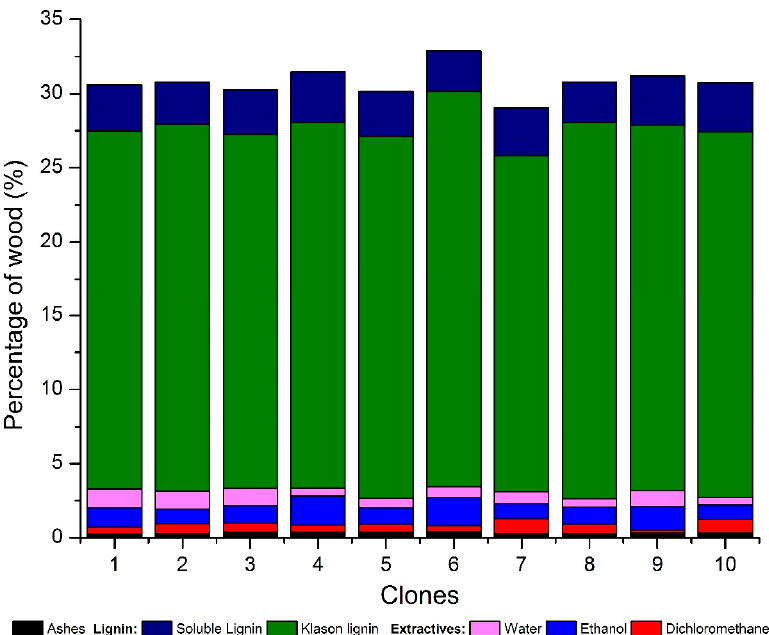
Figure 2. Ash, extractive and lignin contents of the clones of Eucalyptus spp